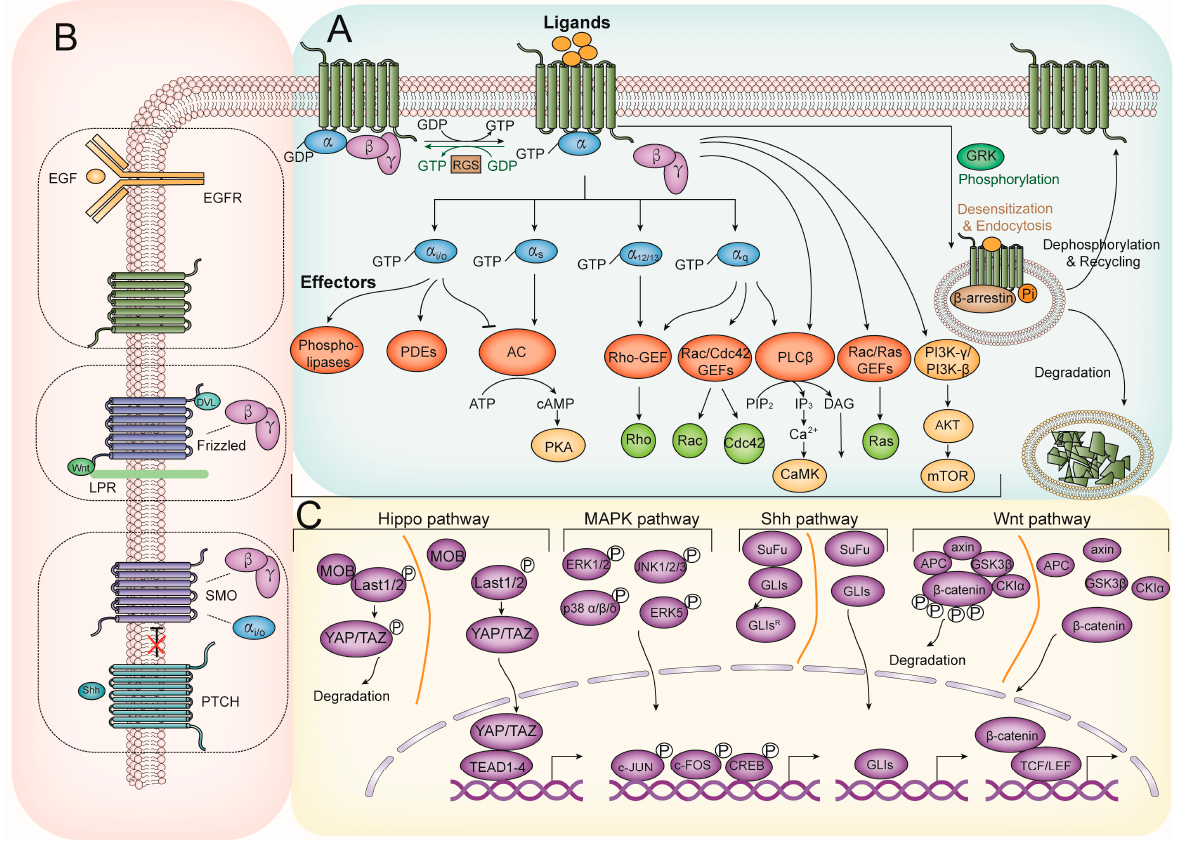
Figure 2. GPCR signaling and its crosstalk with other signaling pathways. ( A ) The most common GPCR-related signaling pathways. Agonist-stimulated GPCRs undergo a conformational change and facilitate the dissociation of G α /G βγ heterotrimer by replacing GDP with GTP on the G α subunit. Subsequently, Ga and G βγ trigger several downstream effectors, including secondary messenger systems, GEFs, Rho, and Ras GTPases, leading to a wide range of biological regulation. Besides the regulators of the G protein, signaling proteins (RGS proteins) promote the heteromeric